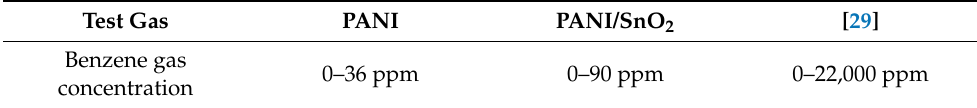
Table 1. Range of benzene gas concentration